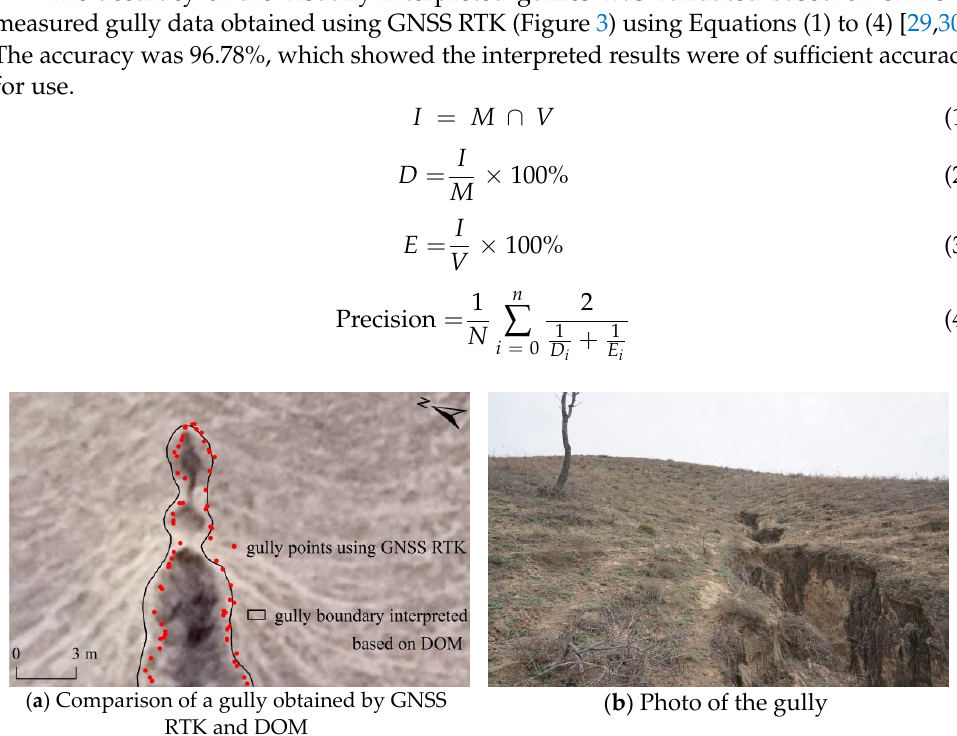
Figure 3. Comparison of a gully obtained by GNSS RTK and DOM, and photo of a gully in the study area. study